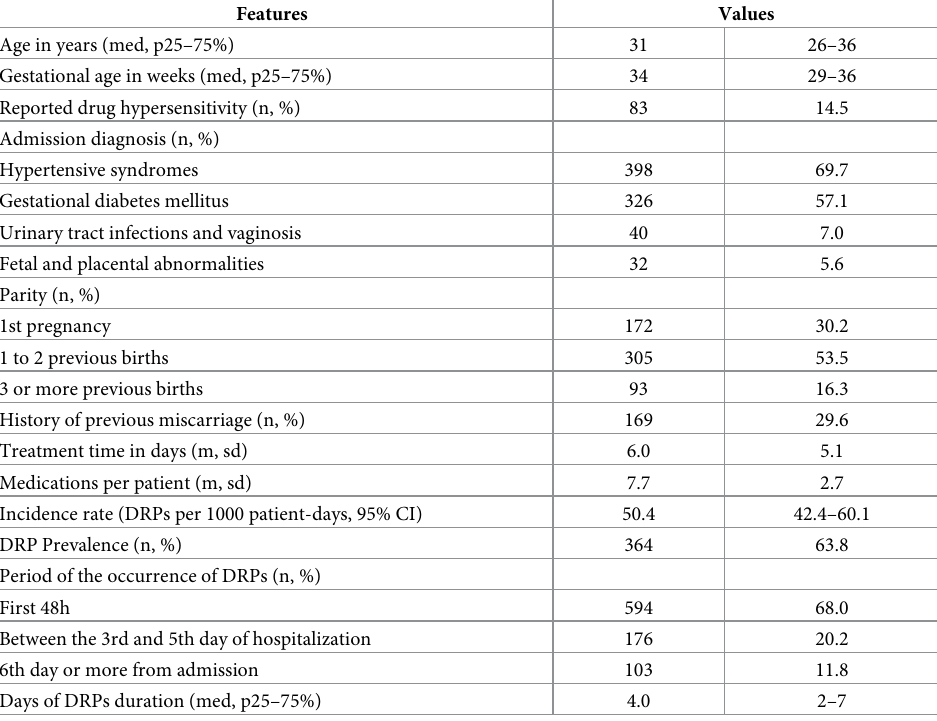
Table 1. Characterization of the study population (n = 571).